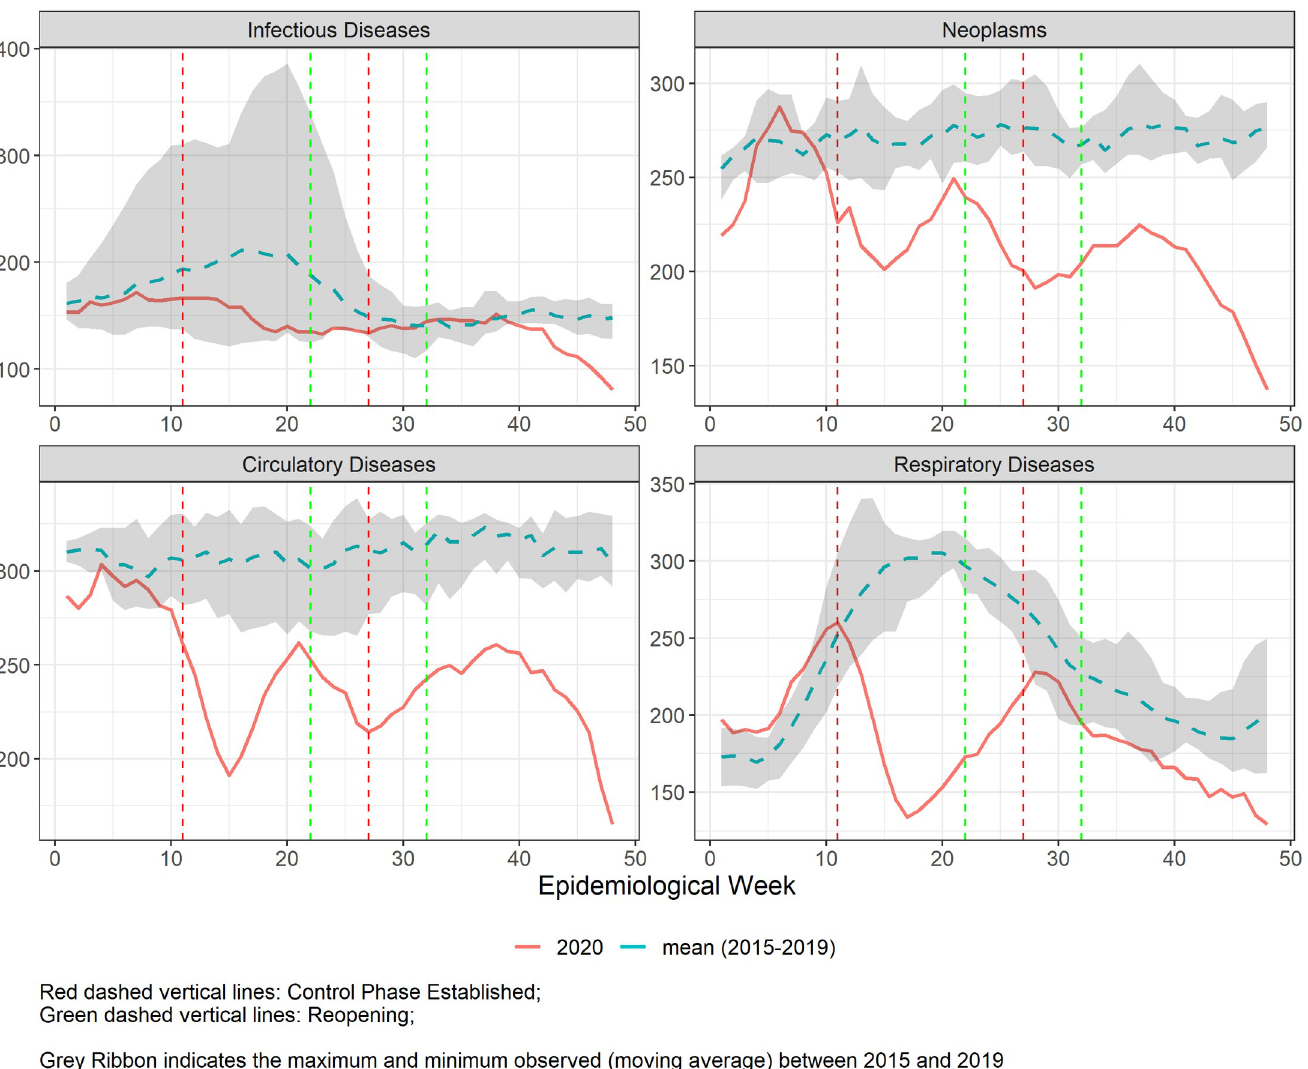
Fig 2. Five-week moving average of number of hospital admissions in Belo Horizonte during the COVID-19 pandemic from epidemiological weeks (EW) 1–48, 2020 (solid line), compared to the mean of 2015–2019 (dashed line), for the 4 selected disease groups. Vertical lines refer to the weeks of control (red) and reopening phases